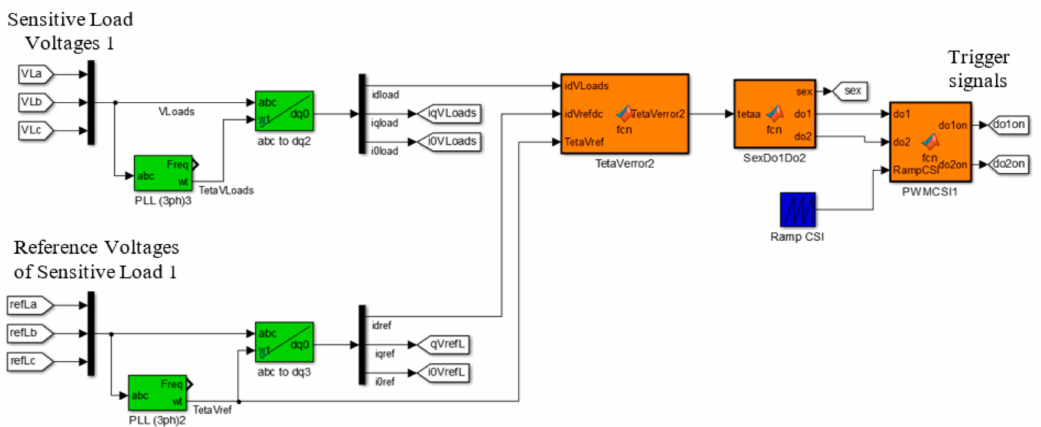
Figure 10. Model of the CSI 1 control algorithm.